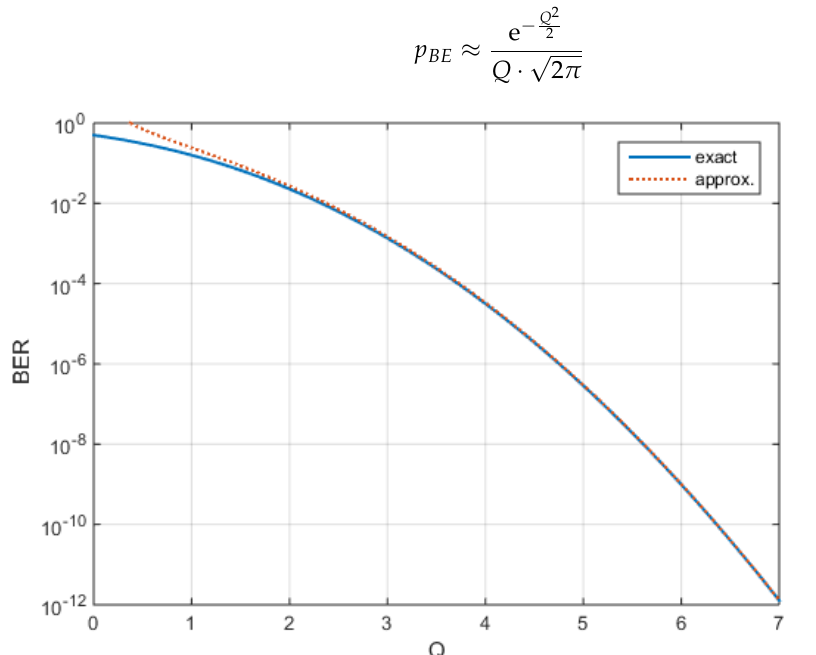
Figure A3. Relation of Q -factor and p BE according to (28).